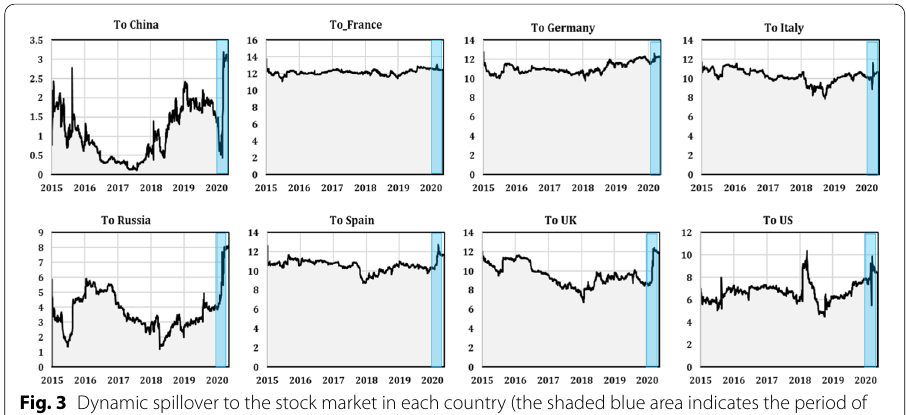
Fig. 3 Dynamic spillover to the stock market in each country (the shaded blue area indicates the period of the COVID-19